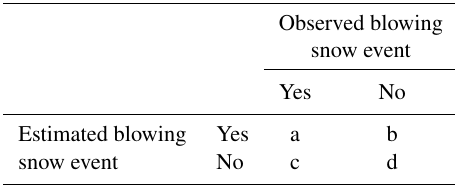
Table 3. Contingency table for blowing snow events and the corre- sponding indices used for the computation of evaluation